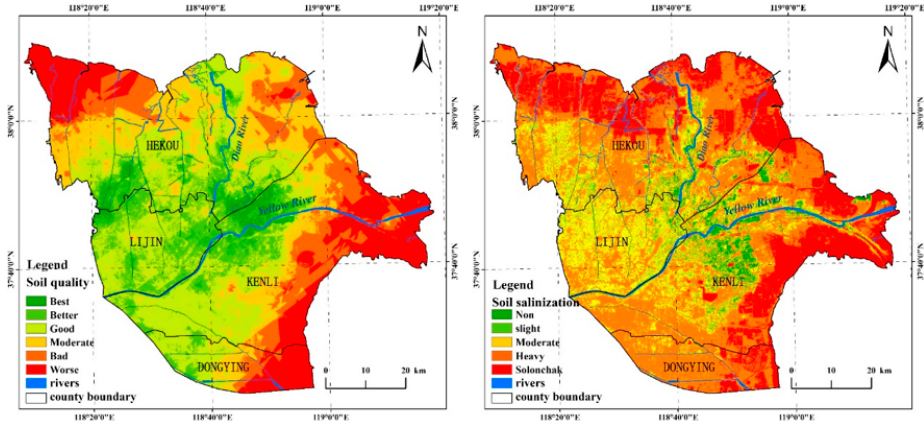
Figure 3. Spatial distributions of the soil quality and the soil salinization in study area.